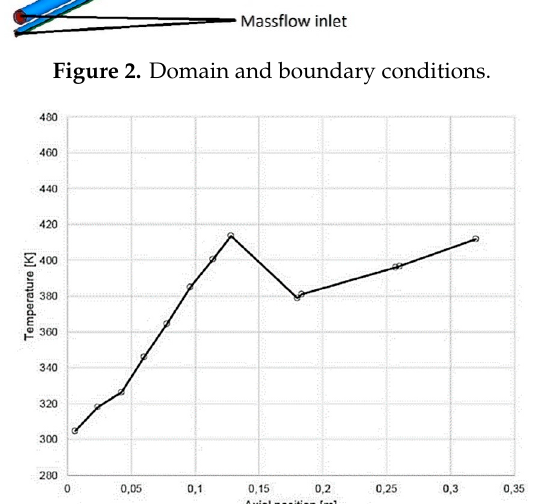
Figure 3. Axial wall temperature profile [1,2].